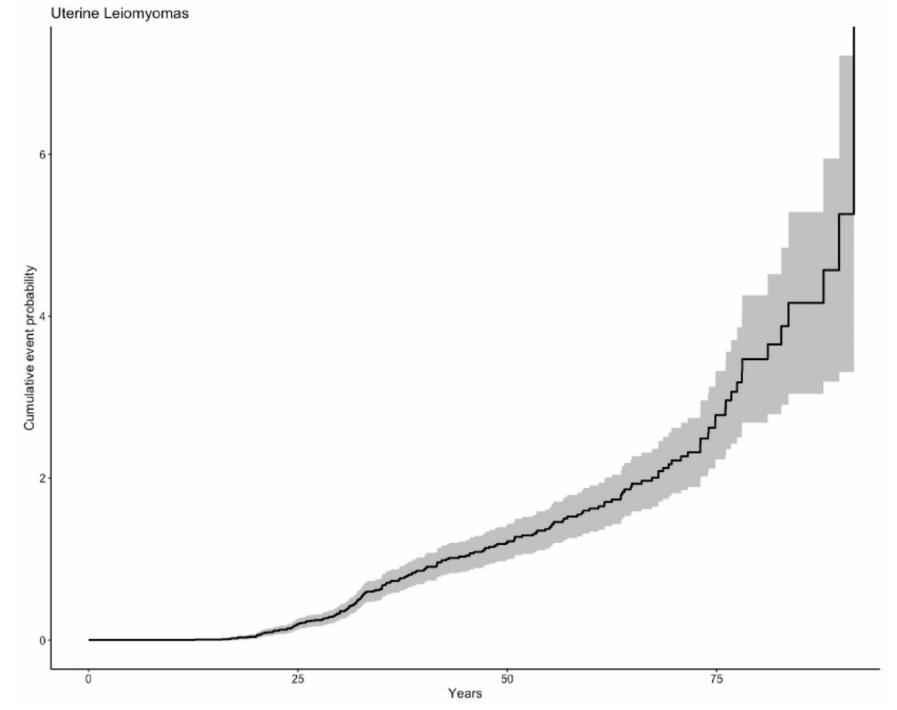
Figure 2. Cumulative incidence of uterine